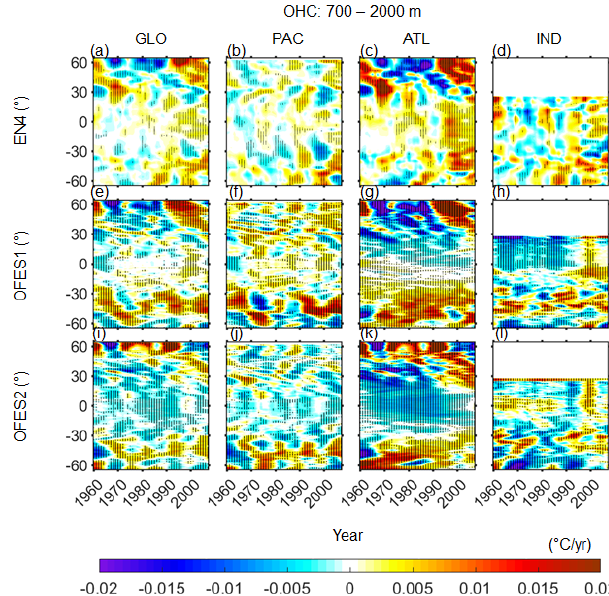
Figure 10. As for Fig. 8 but for the lower layer (700–2000m). Note the different color